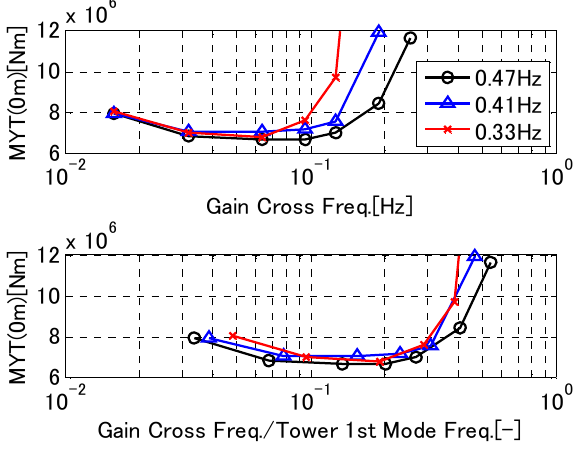
Fig. 5 DELs of Tower Base Bending